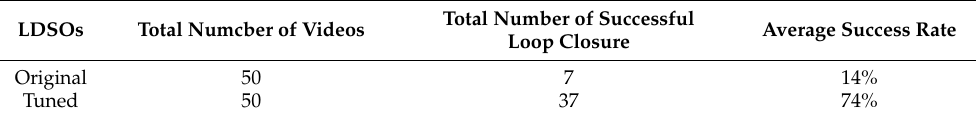
Table 3. Loop closure test on TUM Mono VO dataset: original vs. tuned